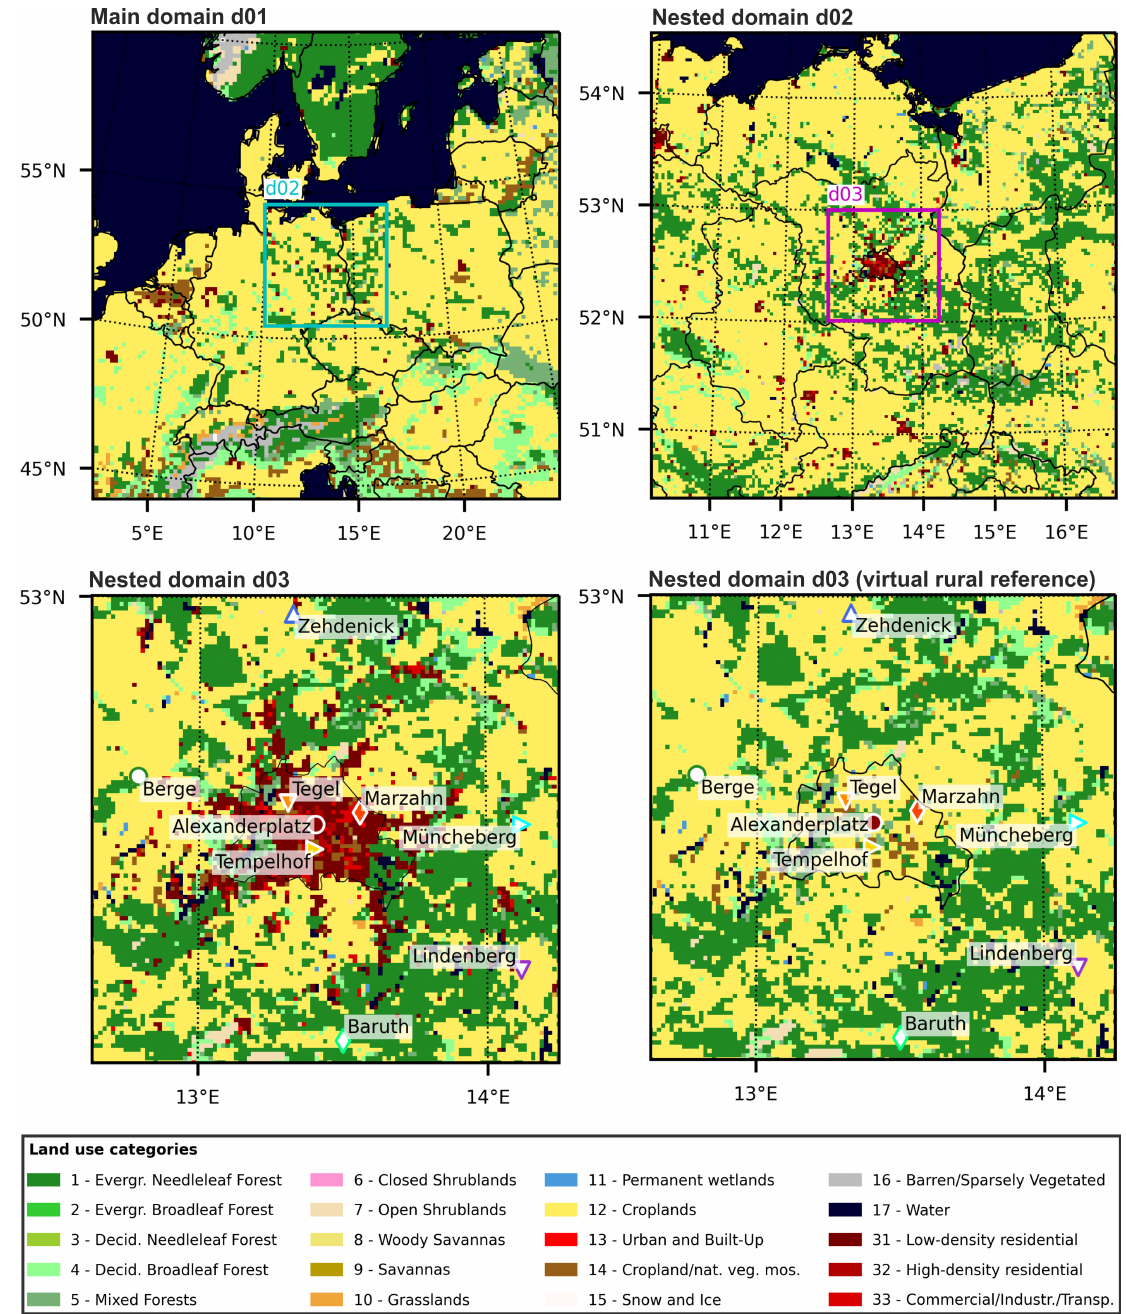
Figure 2. Land use categories using the combined MODIS and CORINE Land Cover (CLC) datasets for the main domain d01 and the nested domains d02 and d03. For the inner domain d03, the modified land use data for the virtual rural reference method is additionally shown, see Section